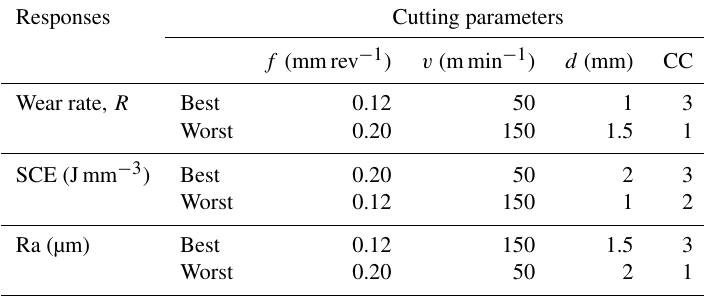
Table 9. Machining condition sets for individual best and worst responses.